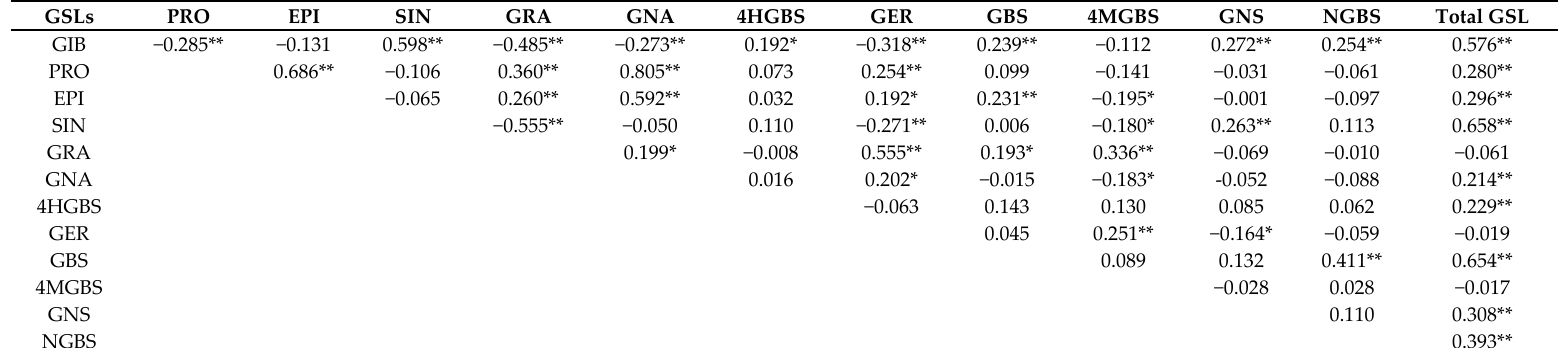
Table 4. Correlation analysis among the GSLs analyzed in this study (n =